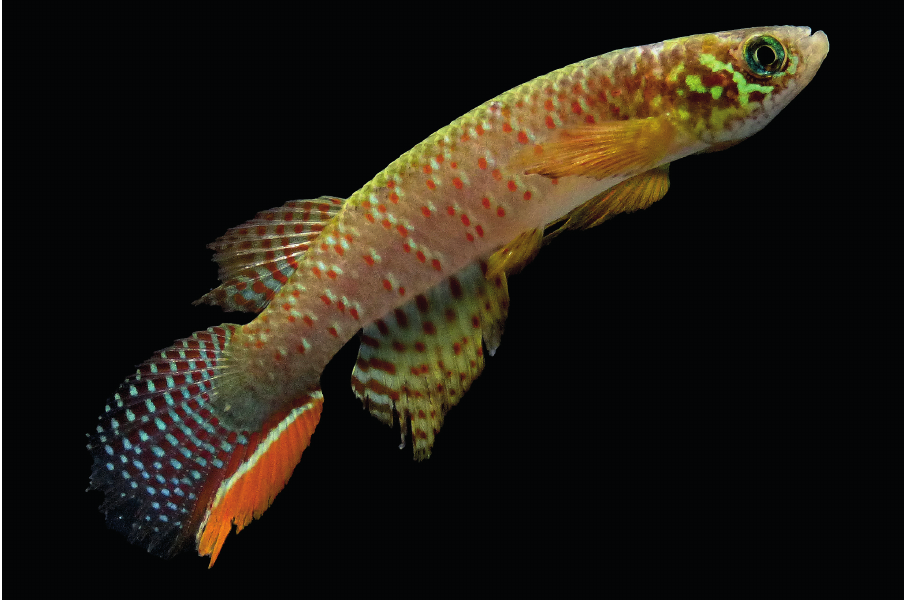
FIGURE 2 | Moema juanderibaensis , MNKP 16539, holotype, male, 41.9 mm SL (2 days after collection, right side), Bolivia, Santa Cruz, Santa Rosa del